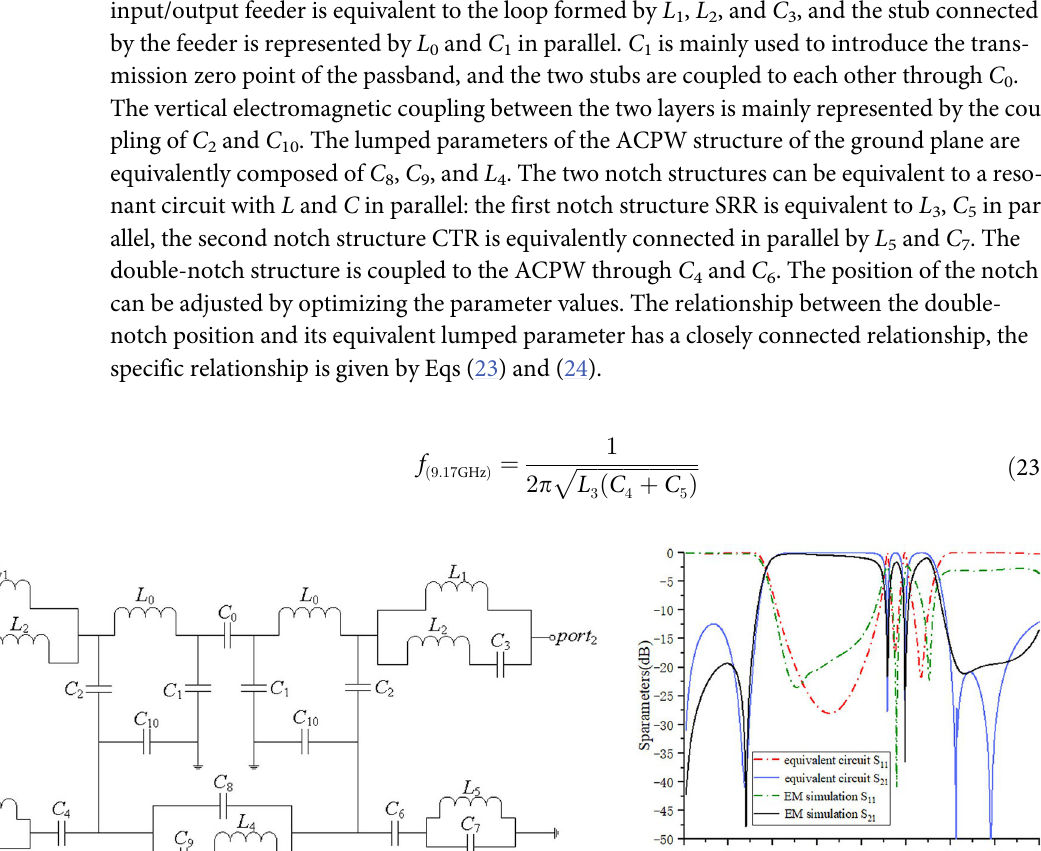
Fig 15. Equivalent circuit structure and comparison of simulation results. (a) lumped parameter equivalent circuit. (b) comparison of equivalent circuit and EM simulation results.